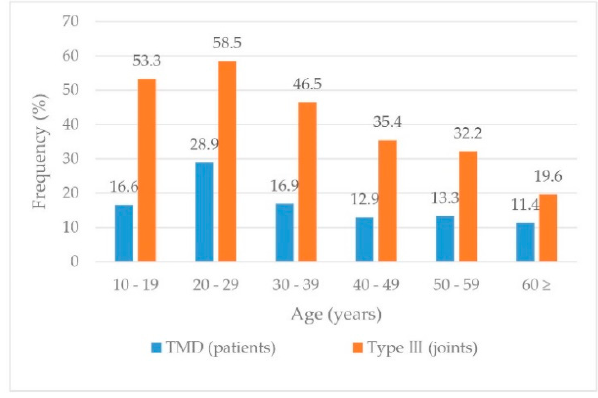
Figure 3. Age distribution of temporomandibular joint disorders (TMD) and type III.